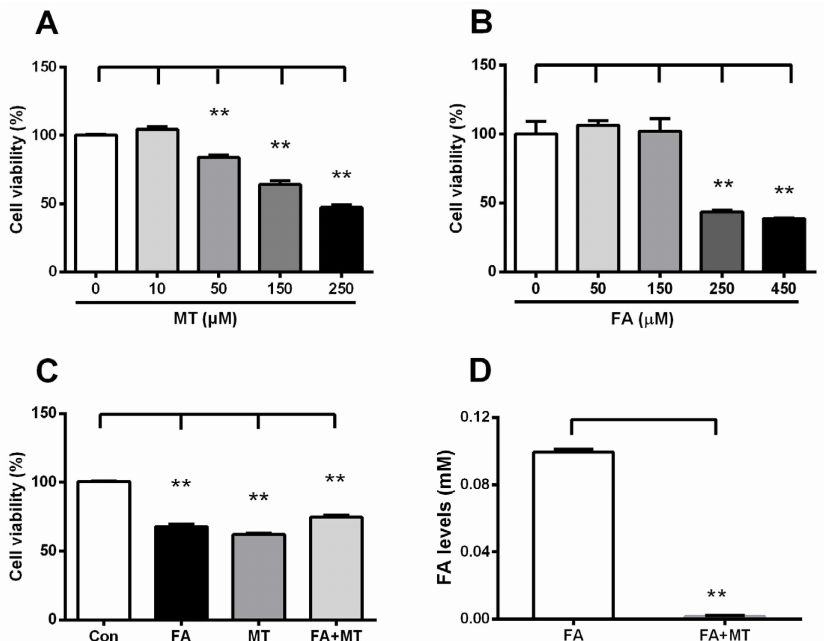
Figure 6. Liquid FA inactivates MT in cultured N2a cell line and in vitro . ( A , B ) A dose-dependent decline in cell viability after MT or FA alone treatment for 24 h ( n = 6 for each group); ( C ) Changes in cell viability after 0.25 mM FA, 0.25 mM MT, and FA combined with MT ( n = 6 for each group); ( D ) A chemical reaction between 0.01 mM FA and 0.01 mM MT in PBS at 37 ˝ C ( n = 6 for each group). ** p <